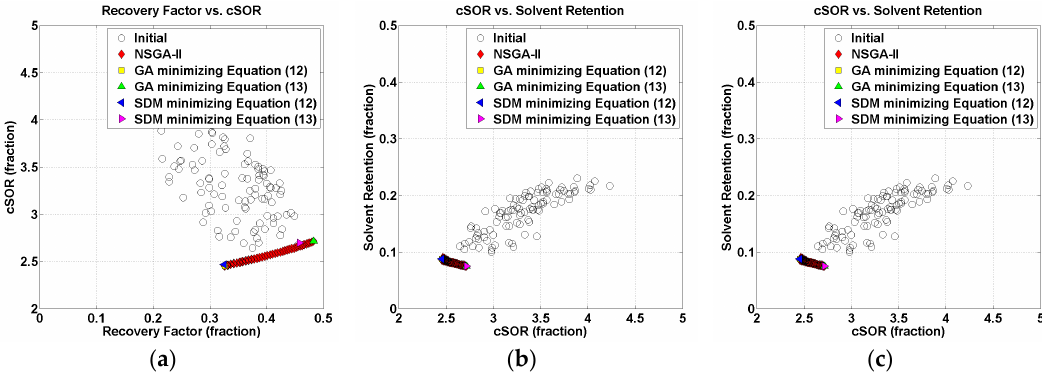
Figure 9. Projection of decision variables in two-dimensional variable space before and after optimization. The evolved solution set obtained from multi-objective optimization includes the optimum solution obtained from global-objective optimization: ( a ) P inj vs. T inj ; ( b ) P inj vs. S frac ; and ( c ) T inj vs. S frac .